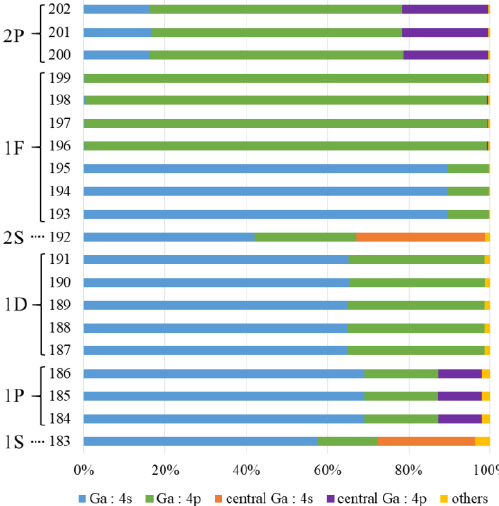
Figure 3. Ratio of atomic orbitals in order to create the superatomic orbitals of the Ga 13 cluster (in- teratomic Ga – Ga bond distance is 2.547 Å ) by means of the Mulliken population analysis.